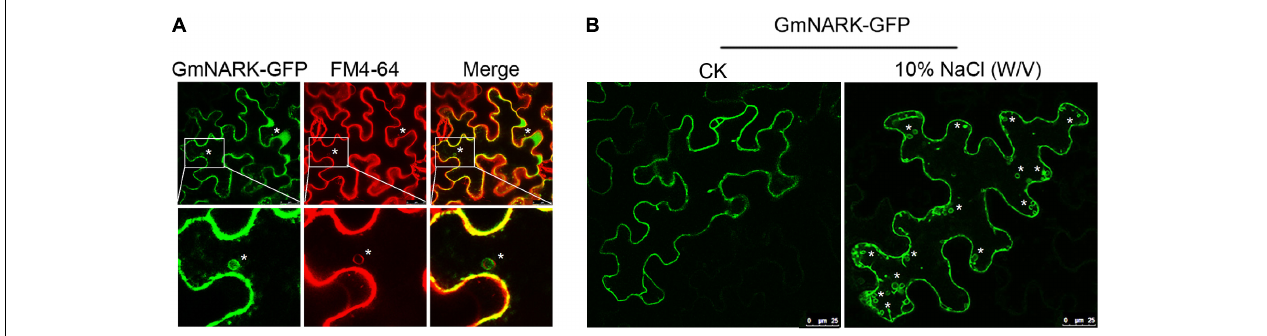
FIGURE 5 | GmNARK-GFP recycles between the plasma membrane and plasma membrane via the endocytic pathway. (A) Colocalization of GmNARK-GFP with FM4-64 (endocytic tracer dye) in vesicles. Epifluorescence confocal images were obtained 48 h after agroinfiltration of tobacco epidermal cells with constructs encoding GmNARK-GFP. “ ∗ ” indicate colocalization of GmNARK-GFP and FM4-64. (B) NaCl-induced vesicles formation of GmNARK. Epifluorescence confocal images were obtained 5 min after 10% (w/v) NaCl treatment. “ ∗ ” indicate the vesicles of GmNARK.